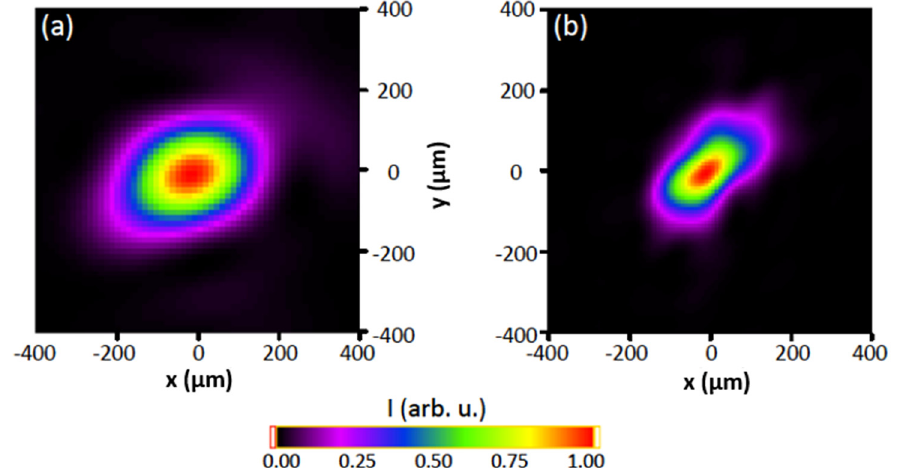
Figure 8. False color maps of the intensity distribution at the position of high harmonic emission for the infrared ( a ) and High Harmonic Generation ( b ) beams (adapted with permission from [26] © The Optical Society).